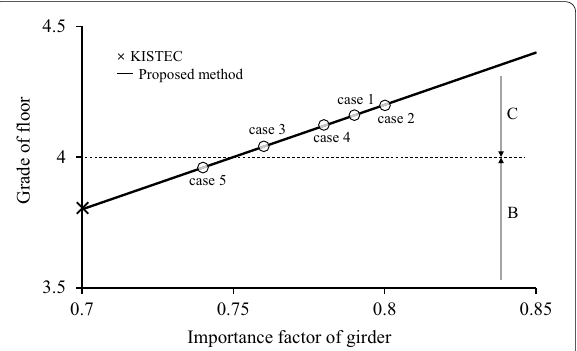
Fig. 8 Grade of floor according to the importance factor (Cases 1–5)